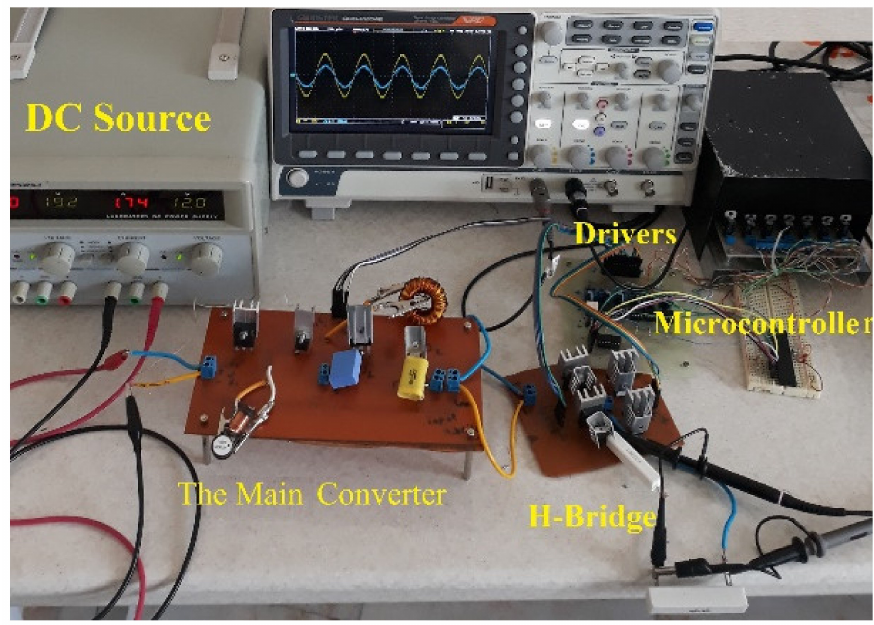
Figure 8. Experimental setup in the laboratory.